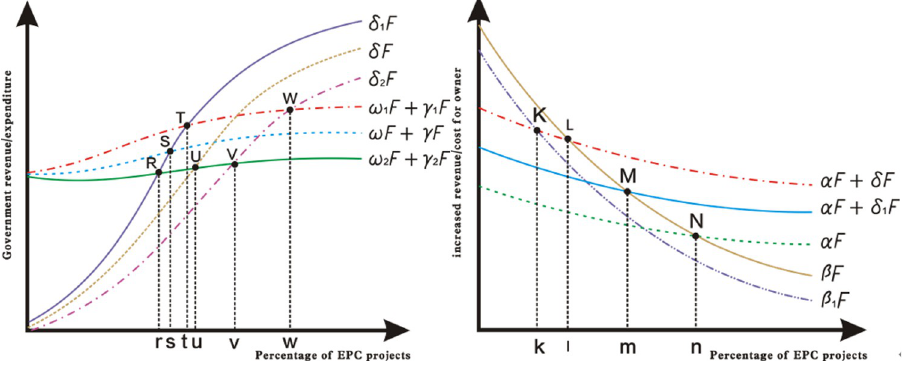
Fig 4. Revenue/Cost analysis for owner or government under different